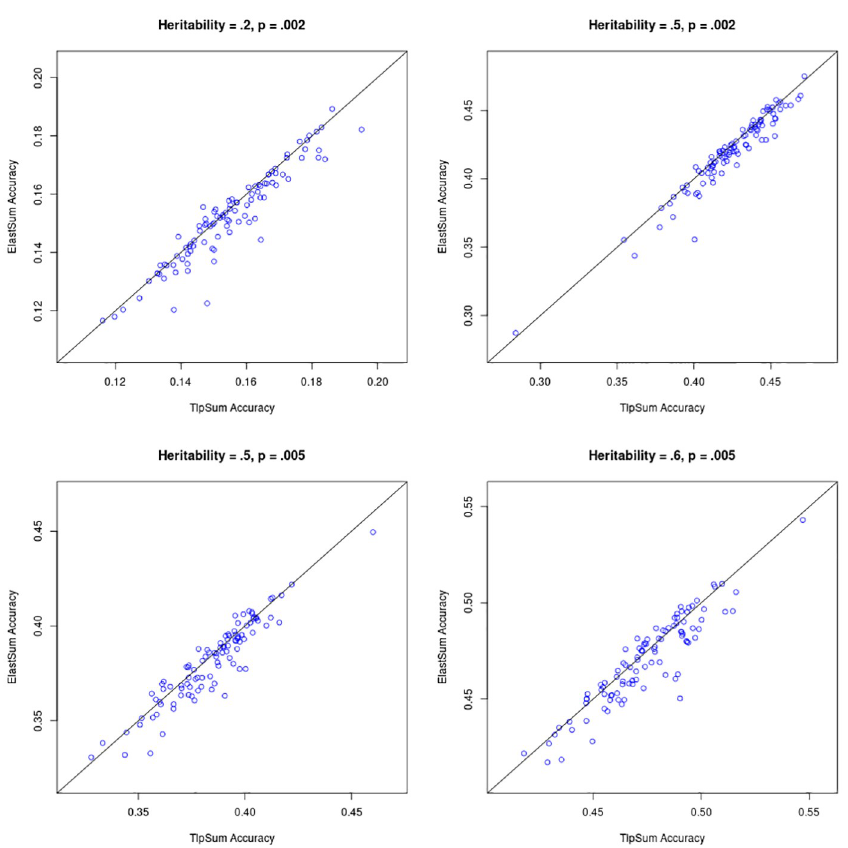
Fig 5. Predictive r 2 on out-of-sample data for TlpSum and ElastSum for each of the 100 replications at each of the four simulation settings. Lines are at a 45 degree angle through the origin, and not a line of best fit. Points below the line indicate better performance of